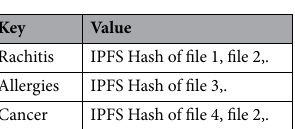
Table 1. Structure of the cloud-based proposed records